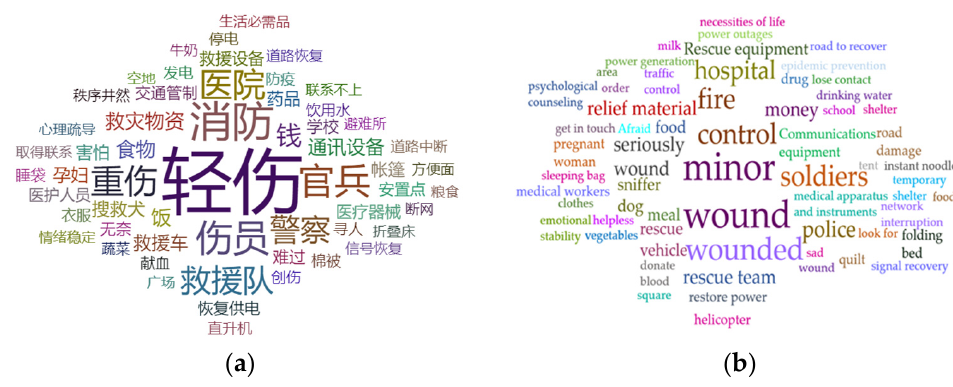
Figure 6. Word cloud of 05SC earthquake. ( a ) In Chinese. ( b ) In English.